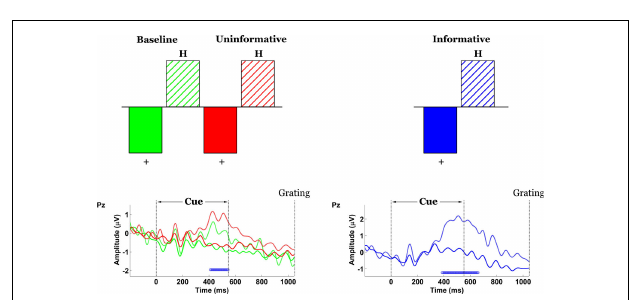
FIGURE 5 | Spatiotemporal patterns of scalp activity that differentiate “ + ” cue and “H” cue trials, separately for the Uninformative/Baseline conditions and for the Informative condition. Top: schematic indicates how the statistical contrasts were coded. Cue- and condition-specifi c ERPs time- locked to cue onset, shown for electrode Pz. Blue dots above the abscissa indicate time points at which the statistical contrast is reliable by bootstrap